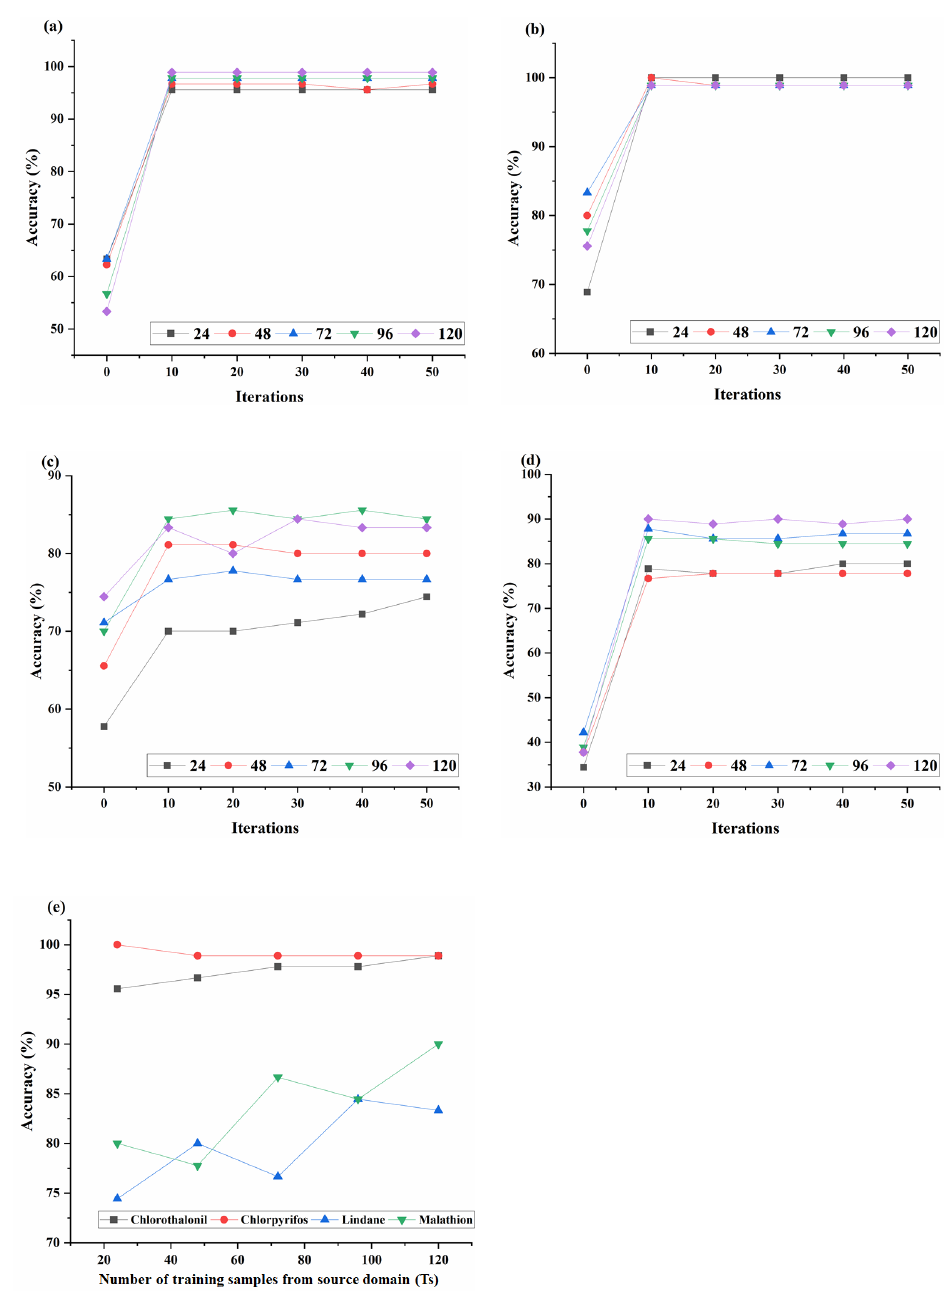
Figure 9. The overall classi fi cation accuracies of semi-quantitative analysis models with di ff erent parameter se tt ings of N and Ts. ( a ) chlorothalonil, ( b ) chlorpyrifos, ( c ) lindane, ( d ) malathion. ( e ) shows the e ff ect of the Ts on overall